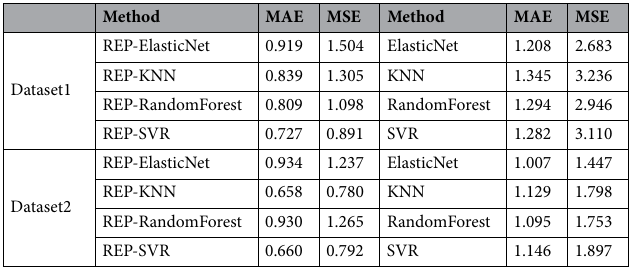
Table 4. Regression performance comparison using Dataset1 and Dataset2.